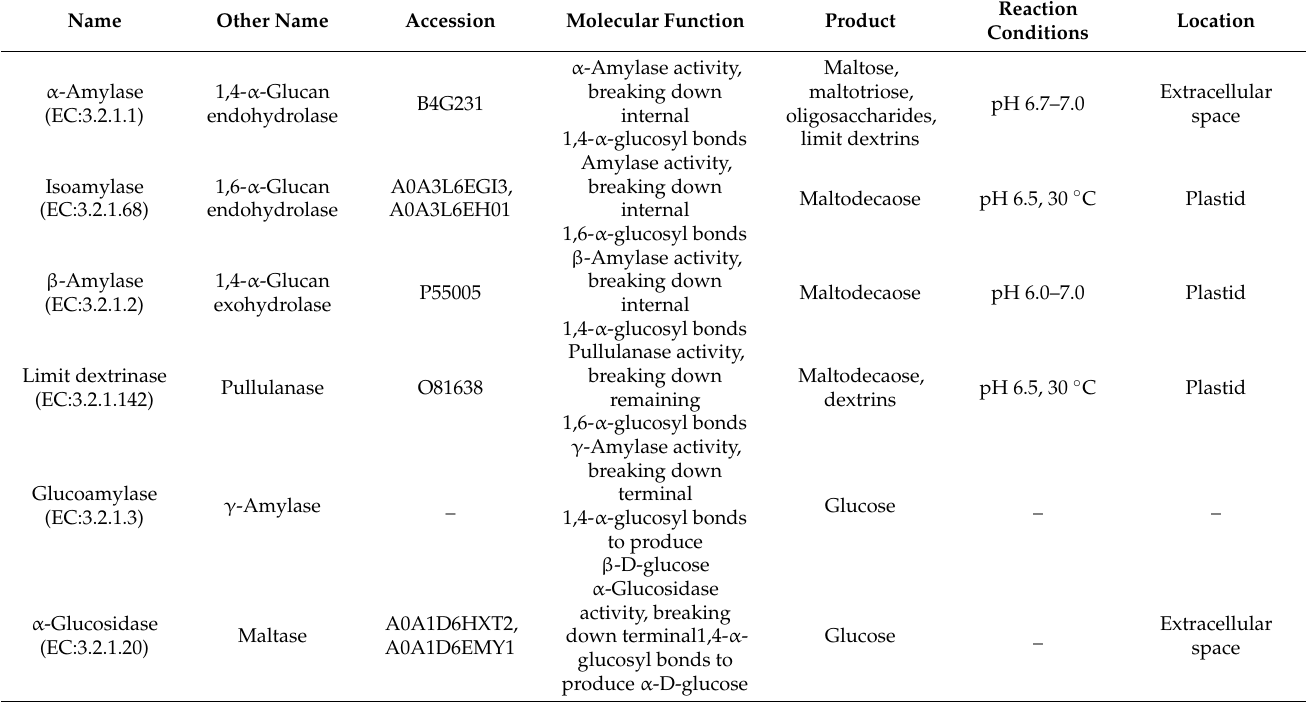
Table 2. Major enzymes identified in the starch degradation during maize seed